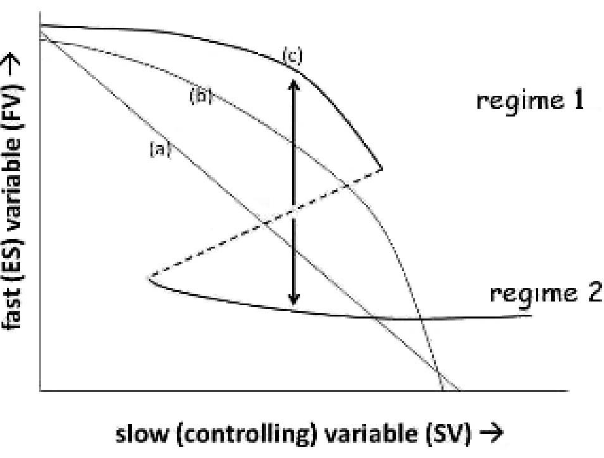
Fig. 1. The relationship between the equilibrium amounts of a fast social–ecological good or service (FV) and the slow variable (SV) that controls it. (a) and (b) are (mathematically) linear relationships. (c) is non-linear, resulting in alternative levels of the FV for the same amount of the SV, separated by an unstable threshold (dotted